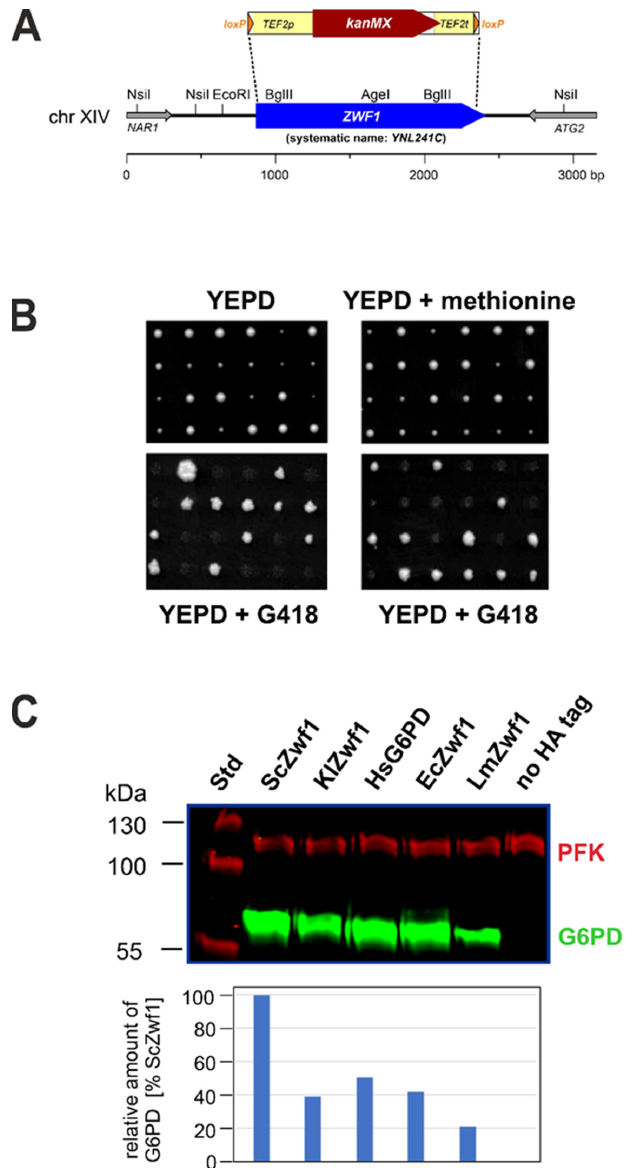
Figure 1. Construction of a yeast zwf1 deletion strain, growth phenotypes and analysis of heterologously produced G6PD enzymes. ( A ) Schematic respresentation of the wild-type ZWF1 locus of Saccharomyces cerevisiae on chromosome 14 and strategy for its substitution by a kanMX marker cassette. Grey arrows respresent flanking genes, the blue arrow the open reading frame of ZWF1 . Some common restriction sites are shown above. The deletion cassette depicted at the top is flanked by loxP sites as targets for the Cre recombinase. ( B ) Tetrad analysis of the heterozygous strain HOD269 ( ZWF1 / zwf1::kanMX ) on rich medium (left upper picture) and rich medium supplemented with methionine. The lower panels show growth after replica-plating onto rich medium supplemented with 200 mg/L of G418 (geneticin). Six representative tetrads are shown for each analysis, out of a